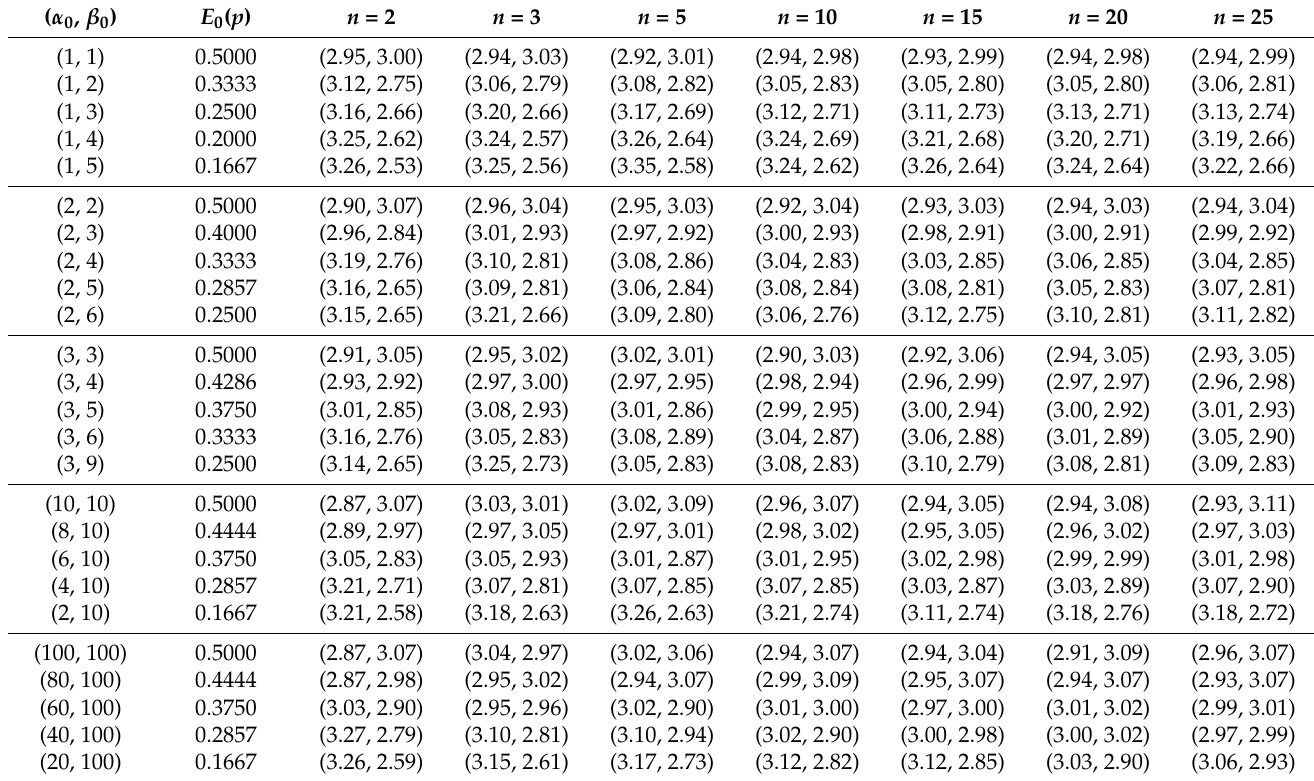
Table 3. The coefficients of the control limits ( k 1 , k 2 ) of the proposed Bayesian exponential weighted moving average (EWMA) variance chart ( λ = 0.05, ARL 0 =